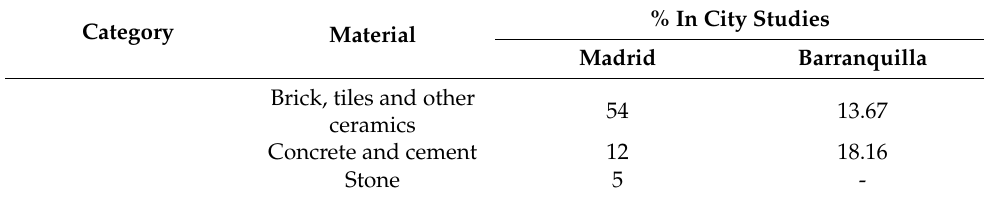
Table 3. Composition and